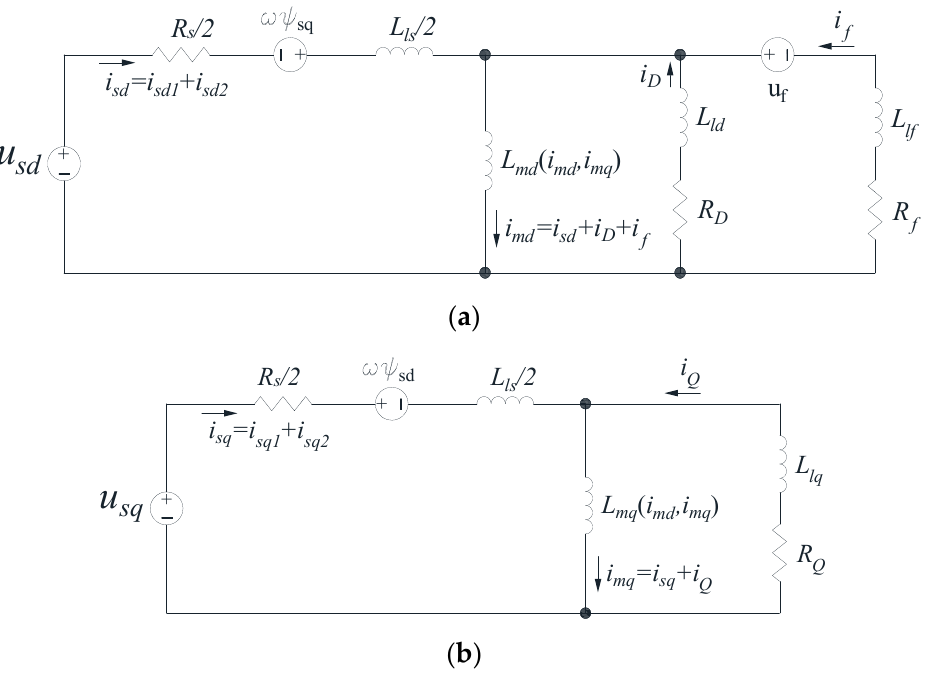
Figure 2. Equivalent circuits for the d - and q -axis of the considered EESM with double star-connected stator winding: ( a ) d -axis equivalent circuit; ( b ) q -axis equivalent circuit.